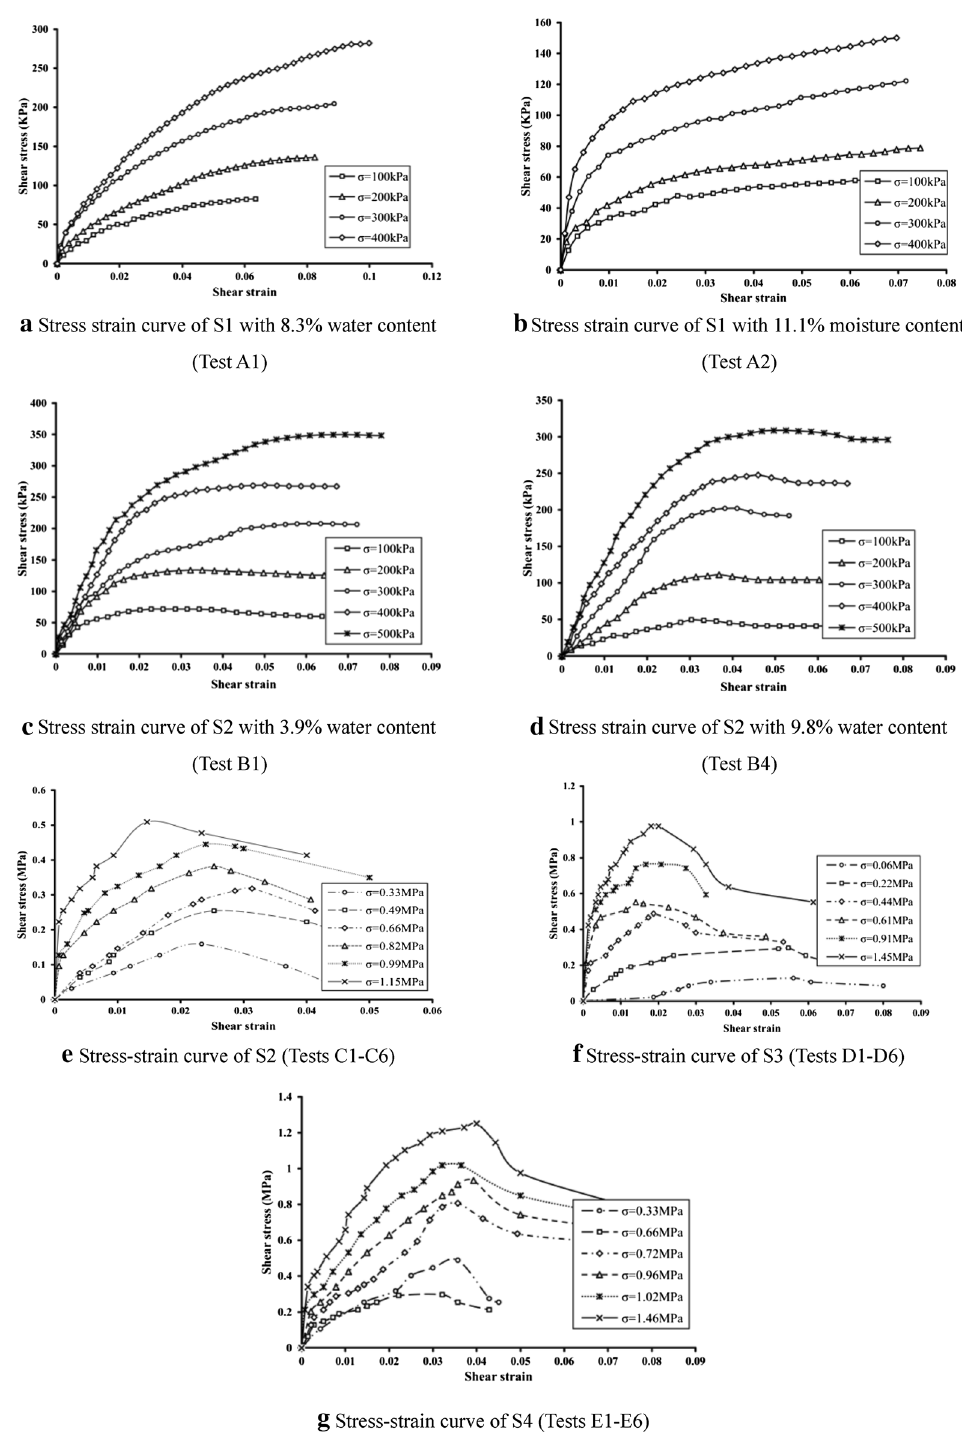
Figure 7. Stress–strain curves of simple direct shear tests ( a – d ) and indoor medium shear tests ( e – g